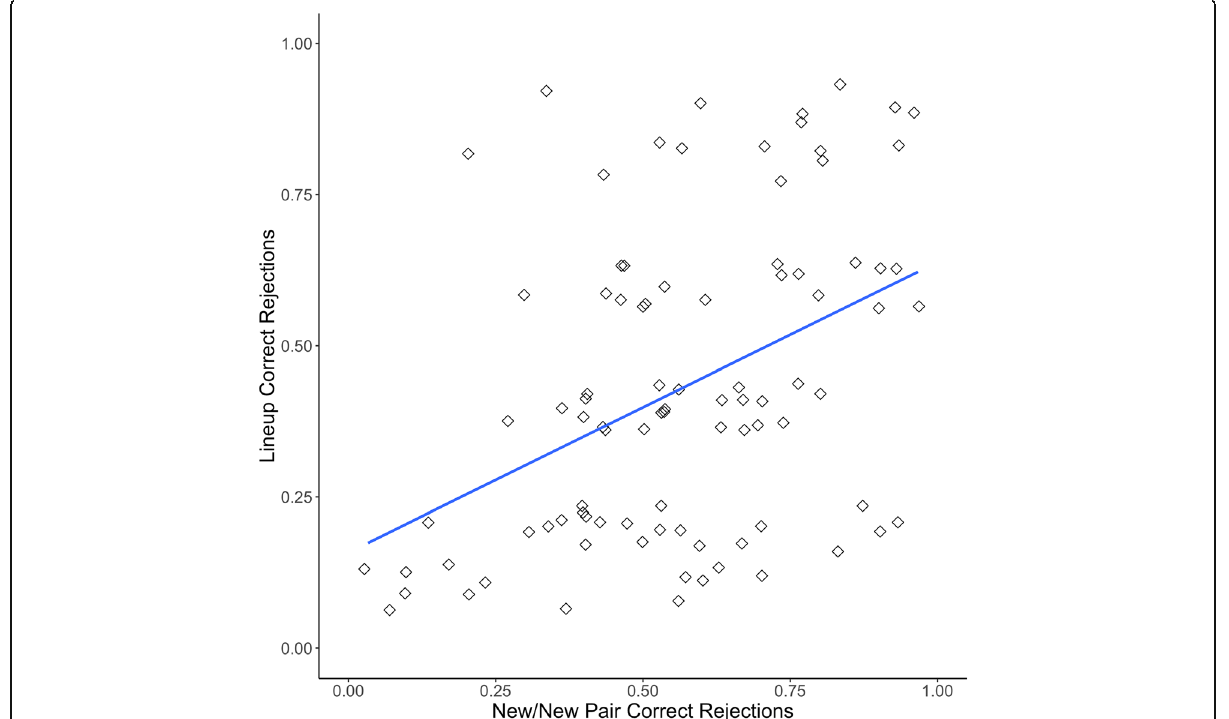
Fig. 2 Proclivity to choose correlation for Experiment 1 with linear trendline, both axes jittered